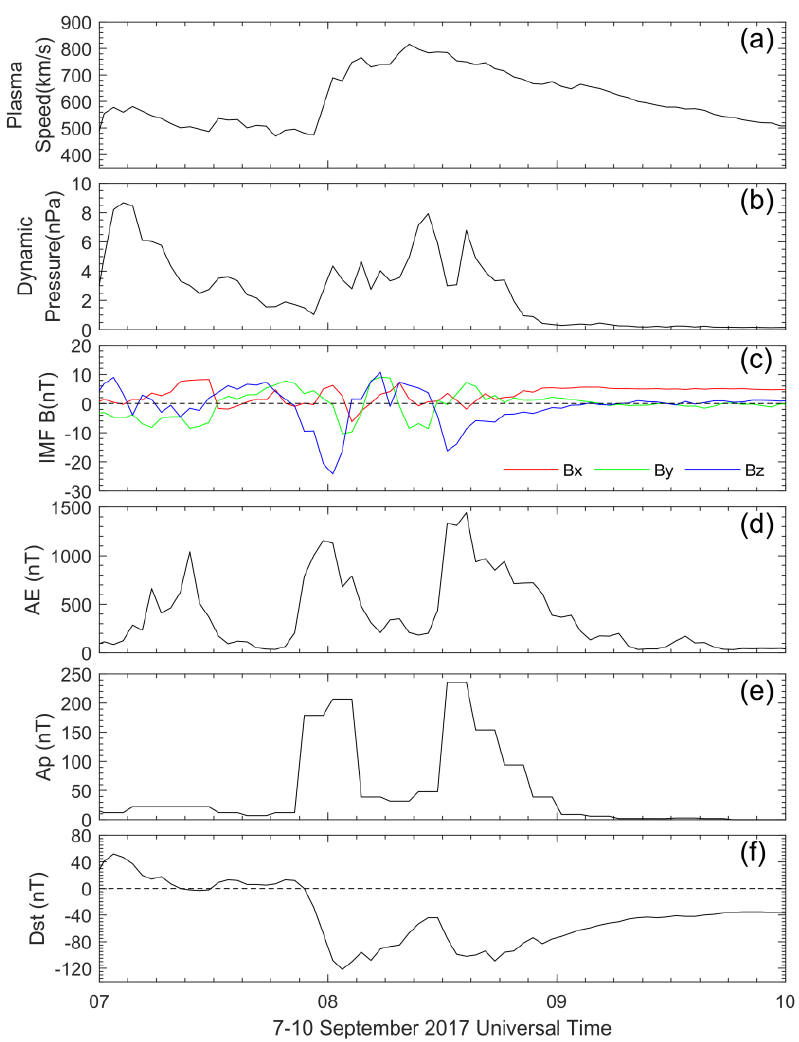
Figure 2. Variations in solar wind and geomagnetic parameters from 7 to 10 September 2017. From top to bottom are ( a ) solar wind velocity, ( b ) solar wind dynamic pressure, ( c ) interplanetary magnetic field Bx, By and Bz, ( d ) AE, ( e ) Ap, and ( f ) Dst.